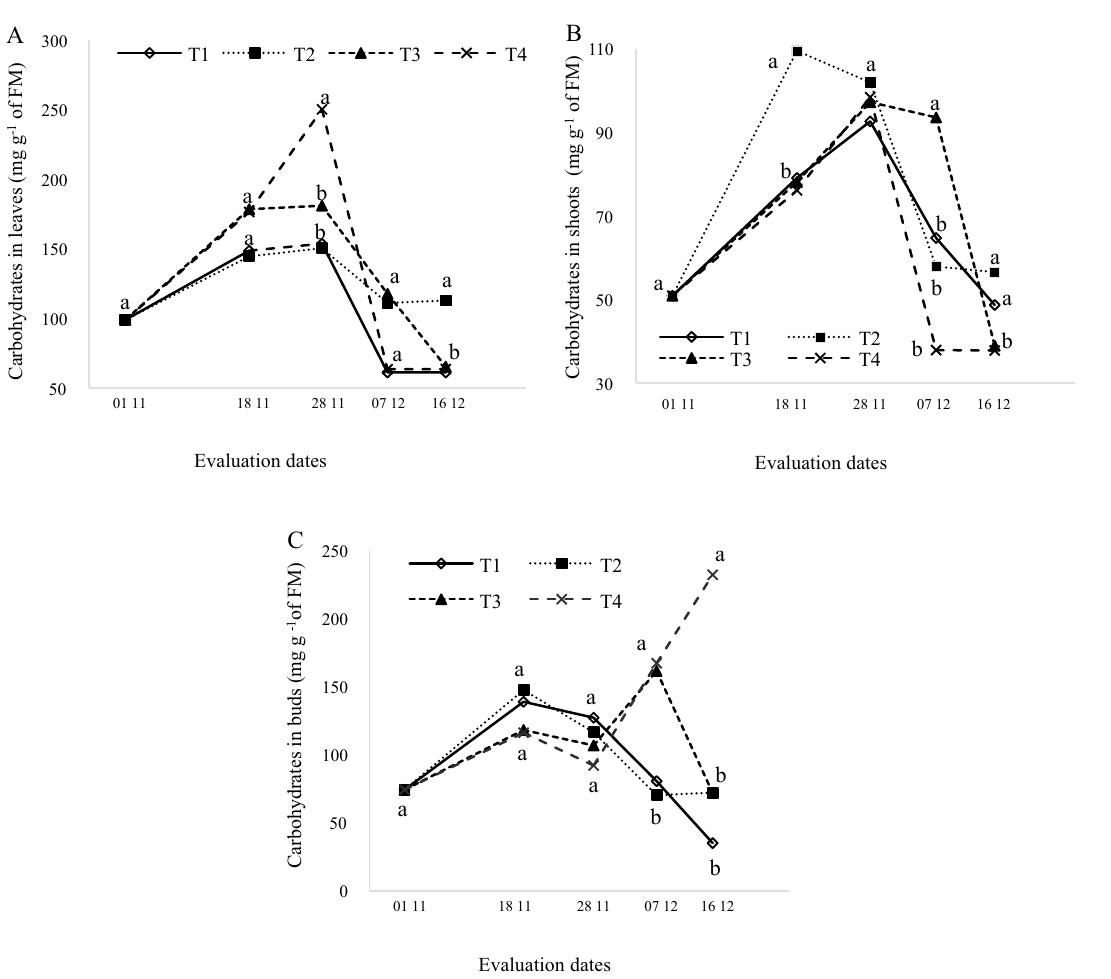
Fig. 2: Total soluble carbohydrates concentrations in leaves (A), shoots (B) and buds (C) of mango cv. Palmer as a function of branch maturation strategy in five evaluation dates. Points with the same letters do not differ in among themselves by Tukey’s test at 1% probability in each evaluation date. T1) biostimulant foliar spray + K fertilizer; T2) foliar spray with biostimulant alternating with K fertilizer; T3) individual foliar sprays (magnesium sulfate, potassium sulfate, sulfur and calcium fertilizers, potassium fertilizer, and Ethrel®; and T4) Control treatment. FM = fresh